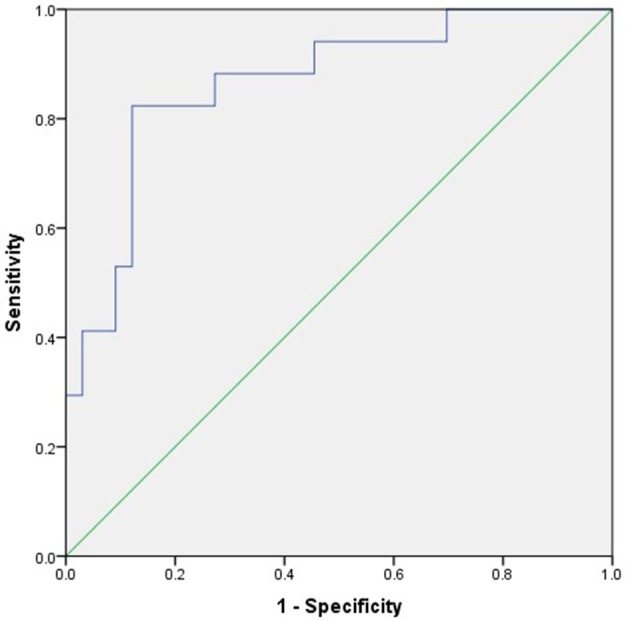
ROC curve of the predictive value of NLR for poor prognosis of AE.